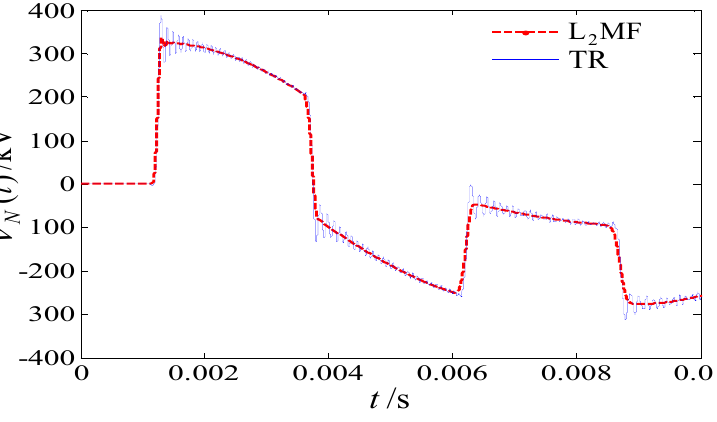
Figure 9. An enlargement of Figure 8.